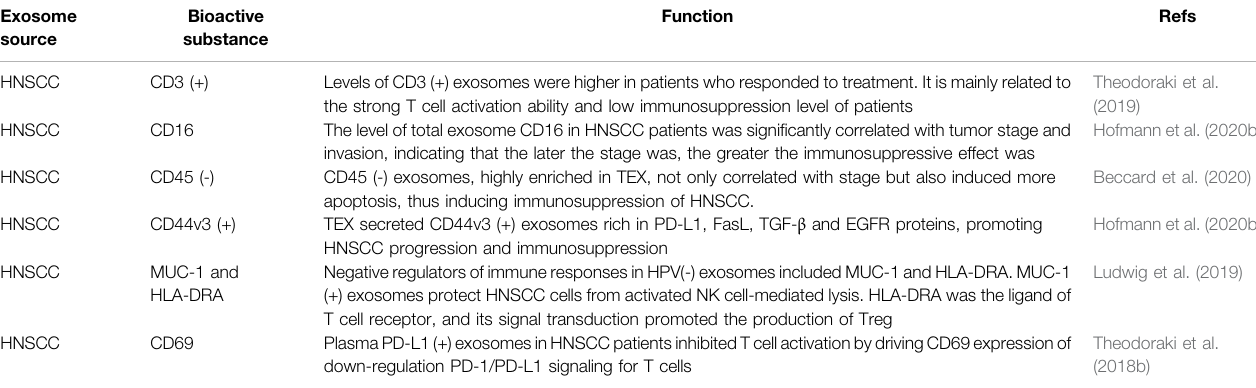
TABLE 4 | Immunosuppression of HNSCC